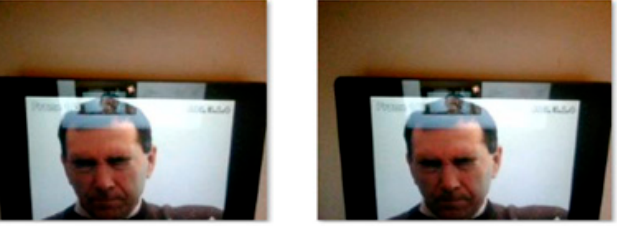
Figure 10. The output of FEAPAS on video 1 using the 2-B-30 strategy. Reprinted/adapted with permission from Ref. [10]. Copyright (@jeffery